Question: According to this chart, does the measure grow or shrink?
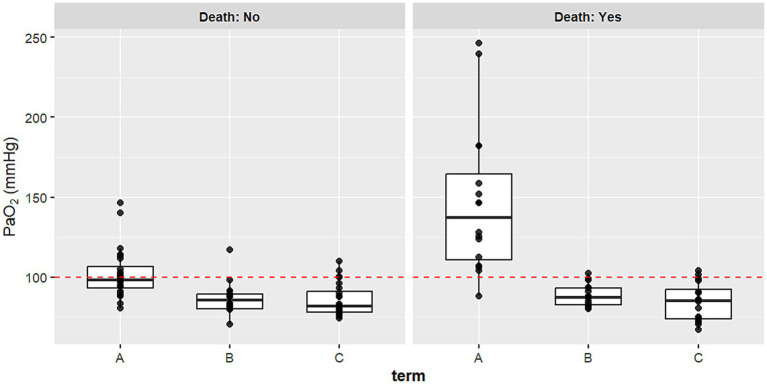
Answer: increasing